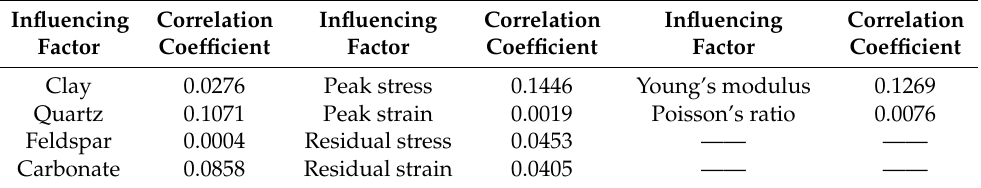
Table 3. Analysis of influencing factors of rock fracture complexity.